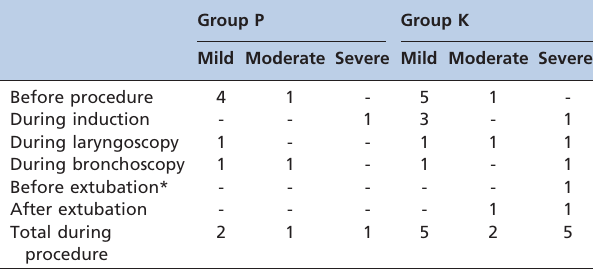
Table 6 - Desaturation